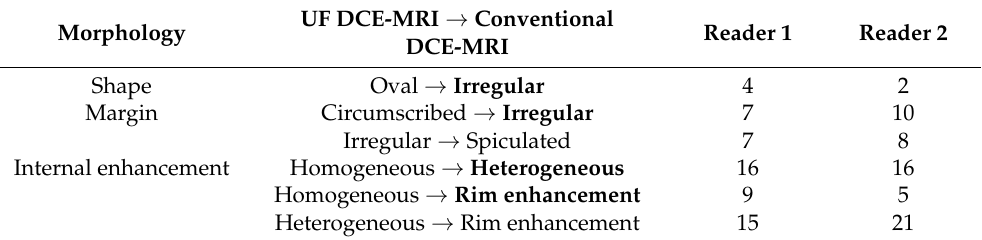
Table 5. Differences in the morphology between the UF DCE-MRI and conventional DCE-MRI.